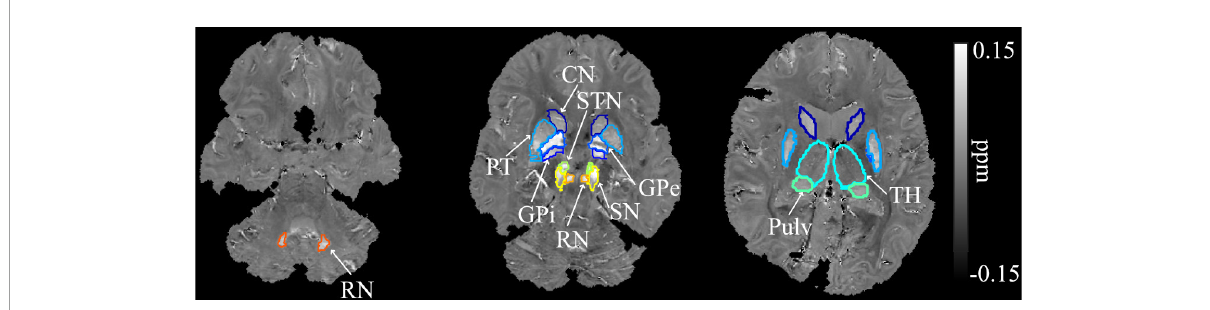
FIGURE1 Example segmentation of the dentate nuclei, basal ganglia, and related iron-rich structures overlaid on the QSM image of a SCA6 participant. DN, dentate nucleus; CN, caudate nucleus; PT, putamen; GPi, globus pallidus internal; GPe, globus pallidus external; RN, red nucleus; SN, substantia nigra; STN, subthalamic nucleus; Pulv, pulvinar; TH,